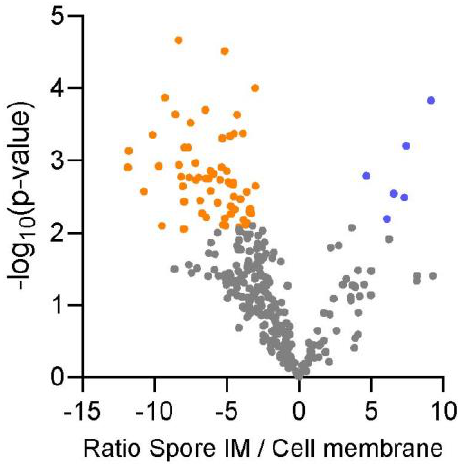
Figure 3. Comparison of spore inner membrane proteins and vegetative cell membrane proteins. Volcano plot of the ratio of iBAQ-values of the spore inner membrane proteins and vegetative cell membrane proteins that were found in both sample types. Significantly more abundant proteins (FDR ≤ 0.01) in the cell membrane (orange) and spore inner membrane (blue) are shown by colored circles.